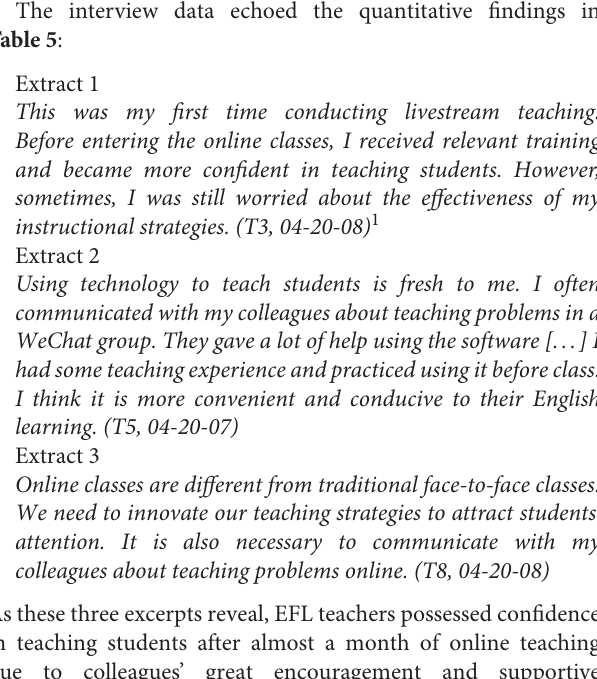
Table 5 : Extract